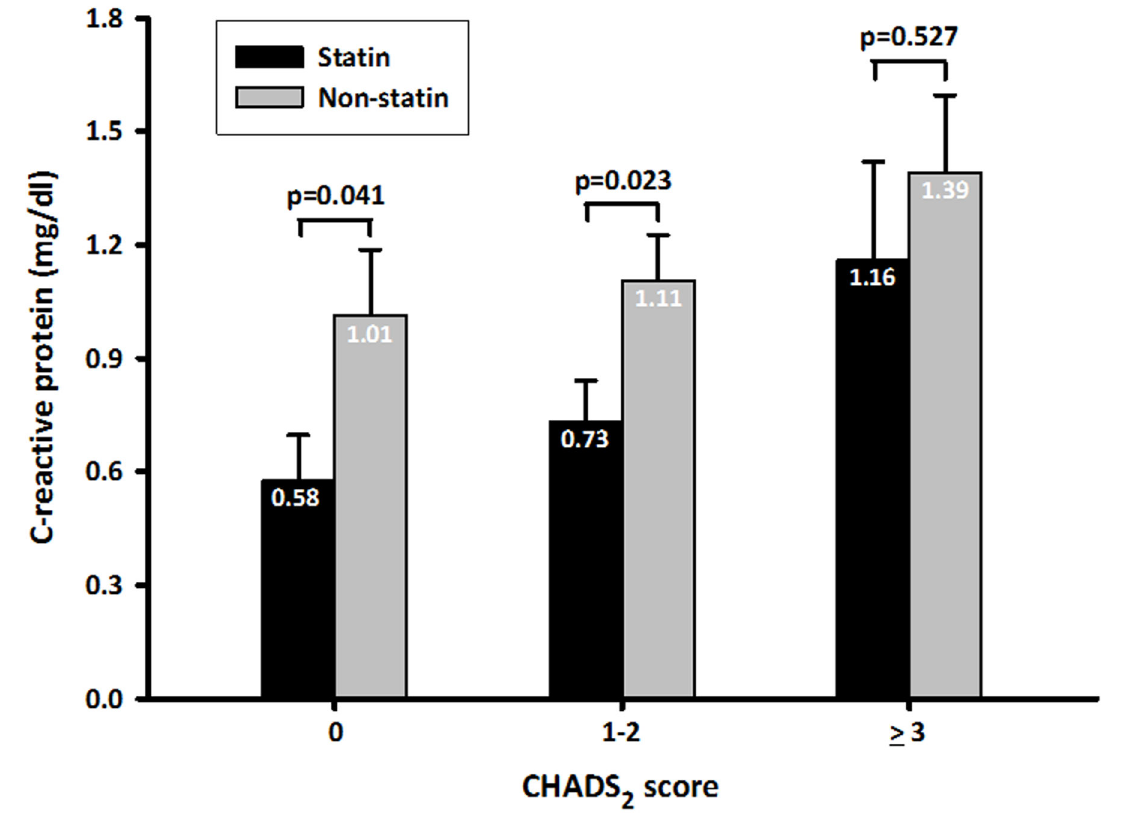
Figure 3. Relationship between CHADS reactive protein. doi: